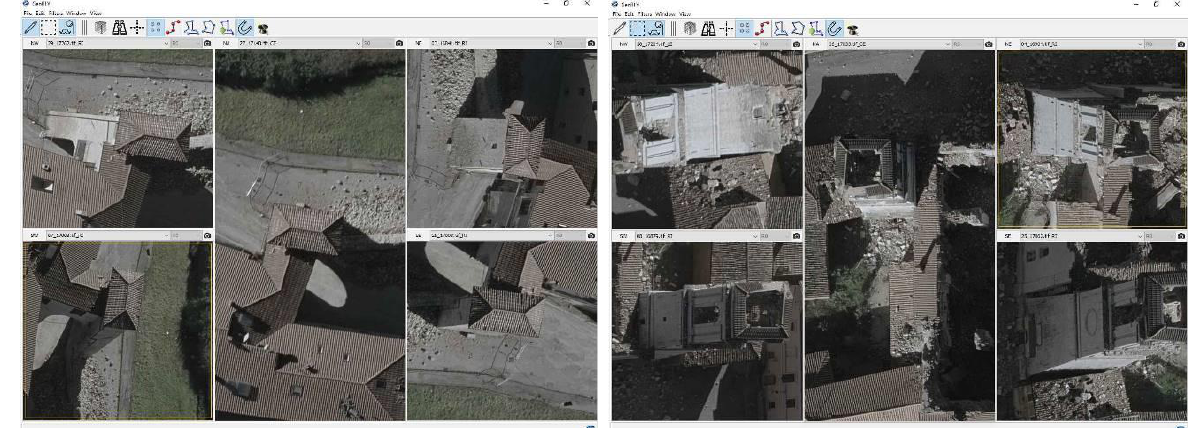
Figure 10. Visualization of two details from the Norcia nadir flight in semi-oblique mode within